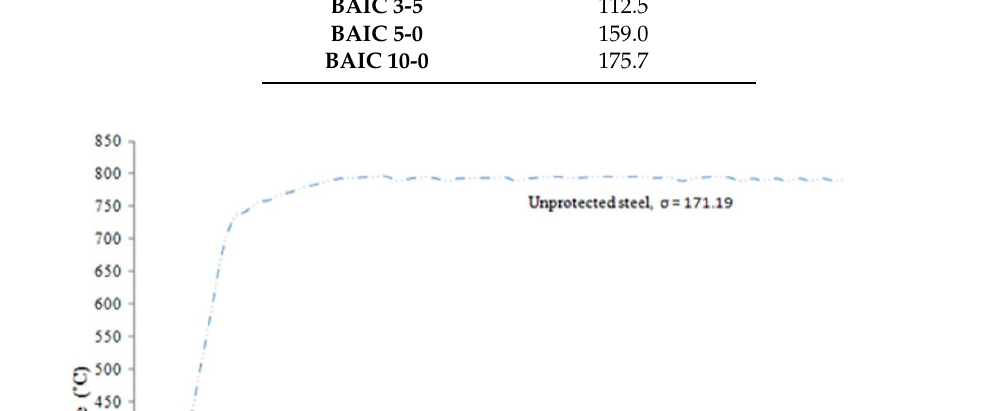
Table 2. End temperatures of BioAsh intumescent coating (BAIC) samples.